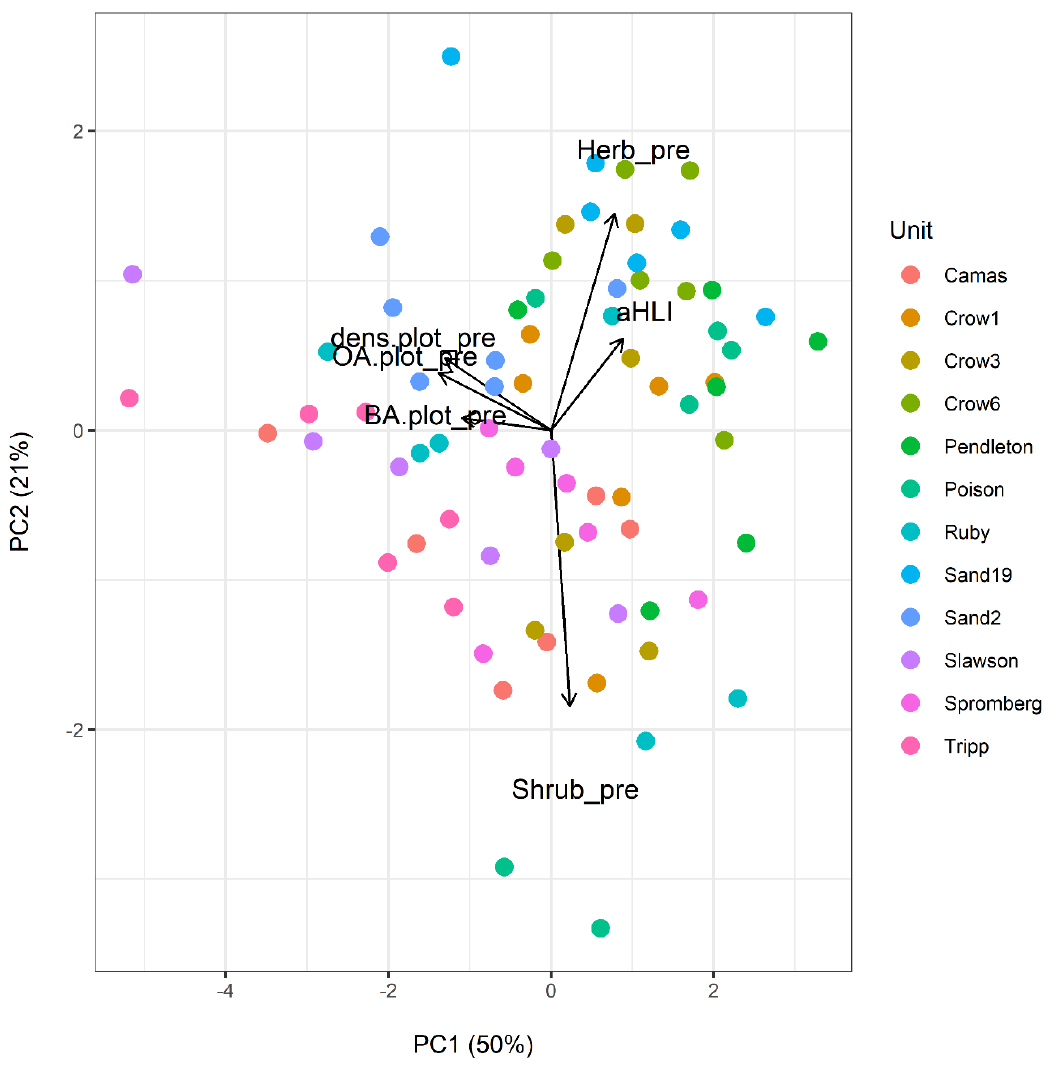
Figure A2. First two principal components from a PCA of an environmental variables (aHLI; an index of heat load) and five pre-treatment vegetation variables: tree density (dens.plot_pre), basal area (BA.plot_pre), OA (OA.plot_pre), mean herb cover (Herb_pre), and mean shrub cover (Shrub_pre). Plots are color-coded by experimental unit.